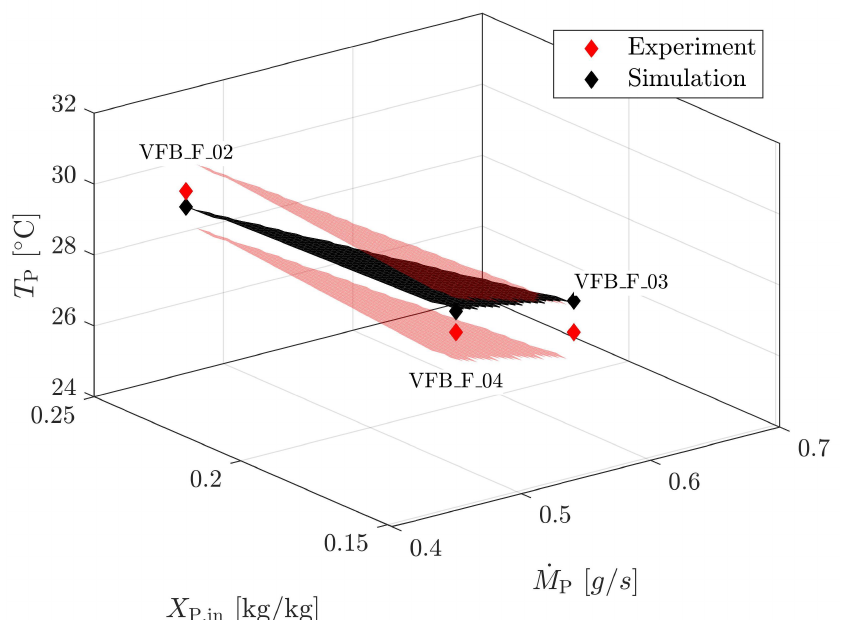
Figure 16. Comparison of measurements and model predictions of particle moisture content ( T P ), plotted against particle mass flow ( ˙ M P,in ) and particle inlet moisture content ( X P,in ), in the VFB pilot-plant-scale dryer for FCC catalyst. The dark gray area designates model predictions; light red areas indicate the upper and lower boundary of measurement errors. Detailed information about the process conditions of the represented data points is given in Table